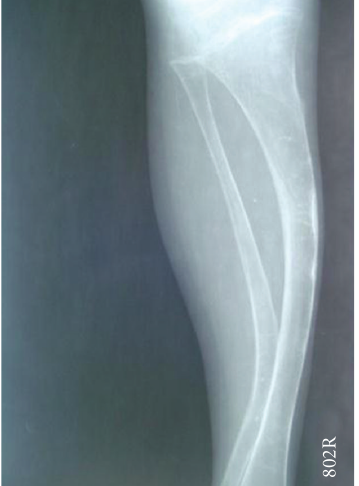
Figure 7: Radiograph showing bowing tibia and